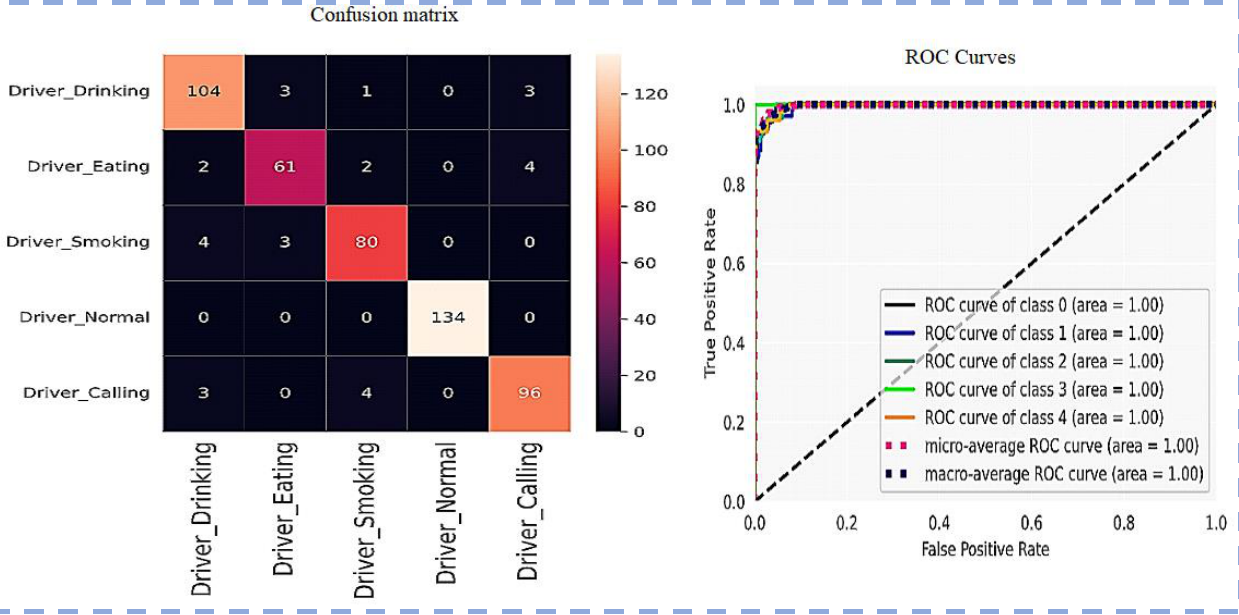
Figure 11. Confusion matrix and ROC Curves using VGG19. Figure 12 uses Inception-v3 to demonstrate the model accuracy and model loss. The diagram shows that the pre-trained model Inception-v3 on the dataset is less precisely tuned than the VGG19 loss function. Additionally, overfitting is essentially not